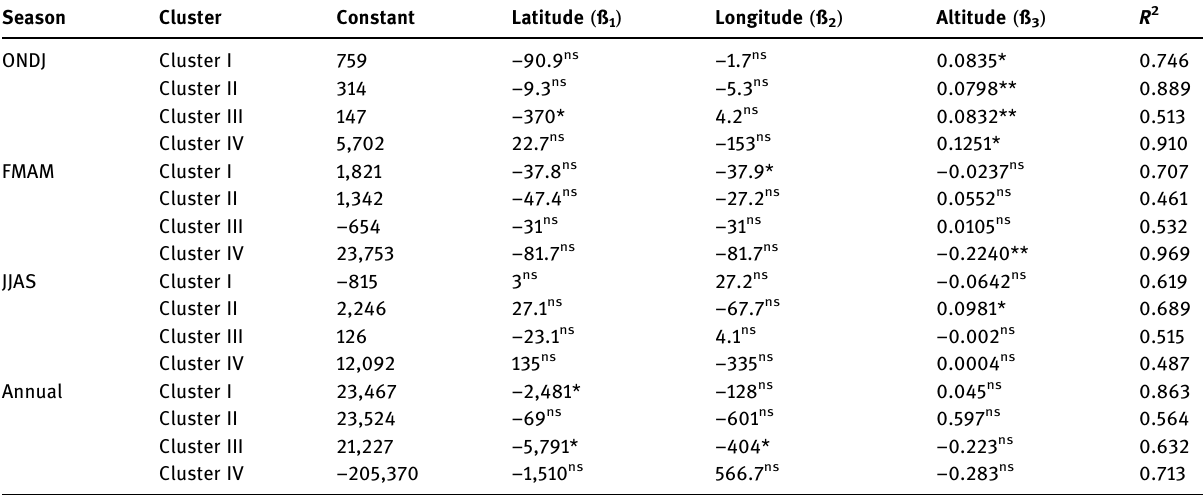
Table 9: Estimate of the parameters ( ß 1 , ß 2 , ß 3 and R 2 ) of the multiple linear regression and coe ffi cient of determination ( R ² ) of average seasonal rainfall according to altitude ( m ) , latitude ( decimal degrees ) , and longitude ( decimal degrees ) , in southern central Ethiopia